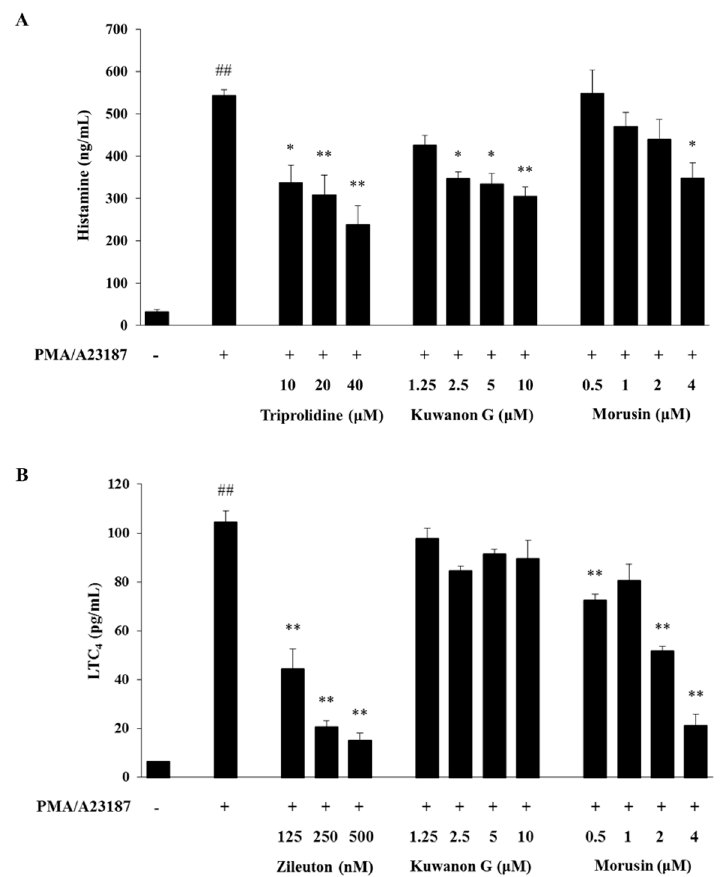
Figure 6. Effects of kuwanon G and morusin on the production of histamine ( a ) and LTC 4 ( b ) in PMA and A23187-stimulated MC/9 mast cells. Triprolidine and zileuton were used as positive controls for the inhibition of histamine and LTC 4 production, respectively. Data are expressed as the mean ± SEM ( n = 3). ## p < 0.01 versus vehicle control cells; * p < 0.05 and ** p < 0.01 versus PMA and A23187-treated cells. LTC 4 , leukotriene C 4 .